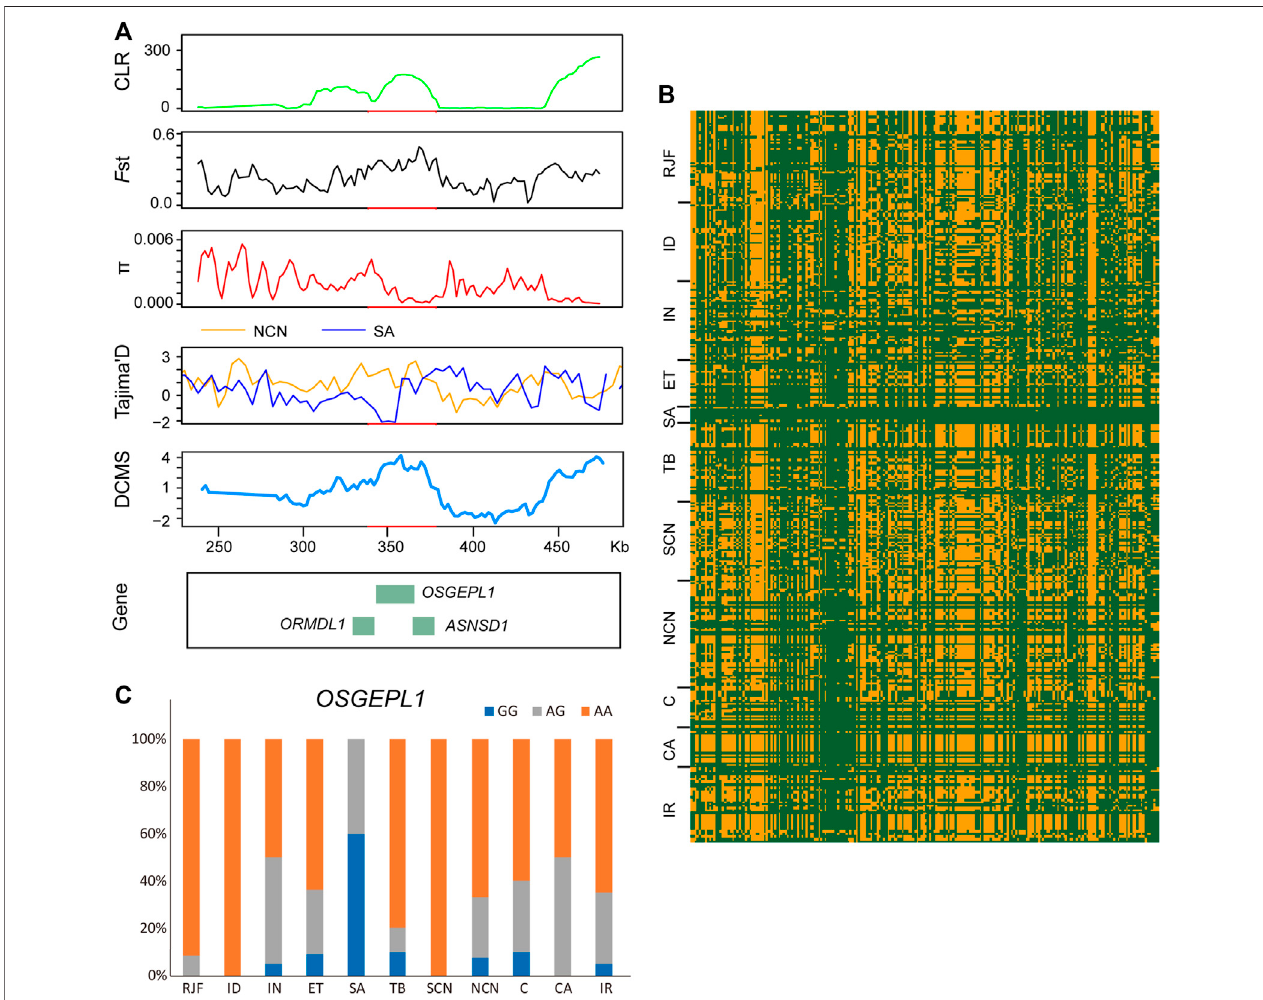
FIGURE5| GenomiccandidateregionswithhighselectionsignalsinSaudiArabianchickens. (A) CLR, F st, π ,Tajima ’ sD,andDCMSanalysisofa40-Kbregionon chromosome7identi fi edbySaudiArabianchickens. (B) haplotypesharingintheregion. (C) allelefrequencyofthemutant OSGEPL1 loci.Themeaningofdifferentcolors is the same as that in Figure 4